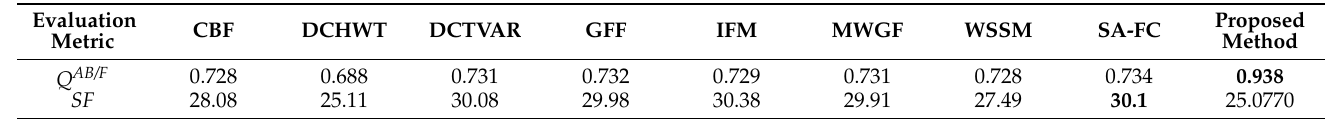
Table 21. The outcomes for the book image and comparisons with existing techniques in the literature ([30]).